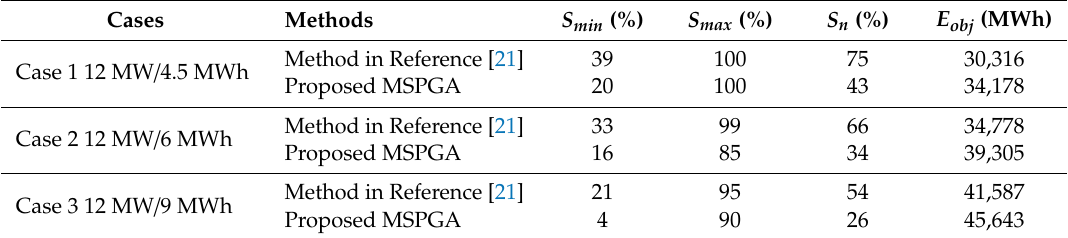
Table 8. Optimal state-of-charge (SOC) range comparison with previous study.